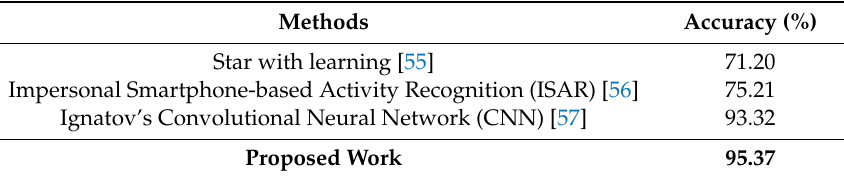
Table 7. Comparison results of the proposed method over other state-of-the-art methods using the WISDM dataset.